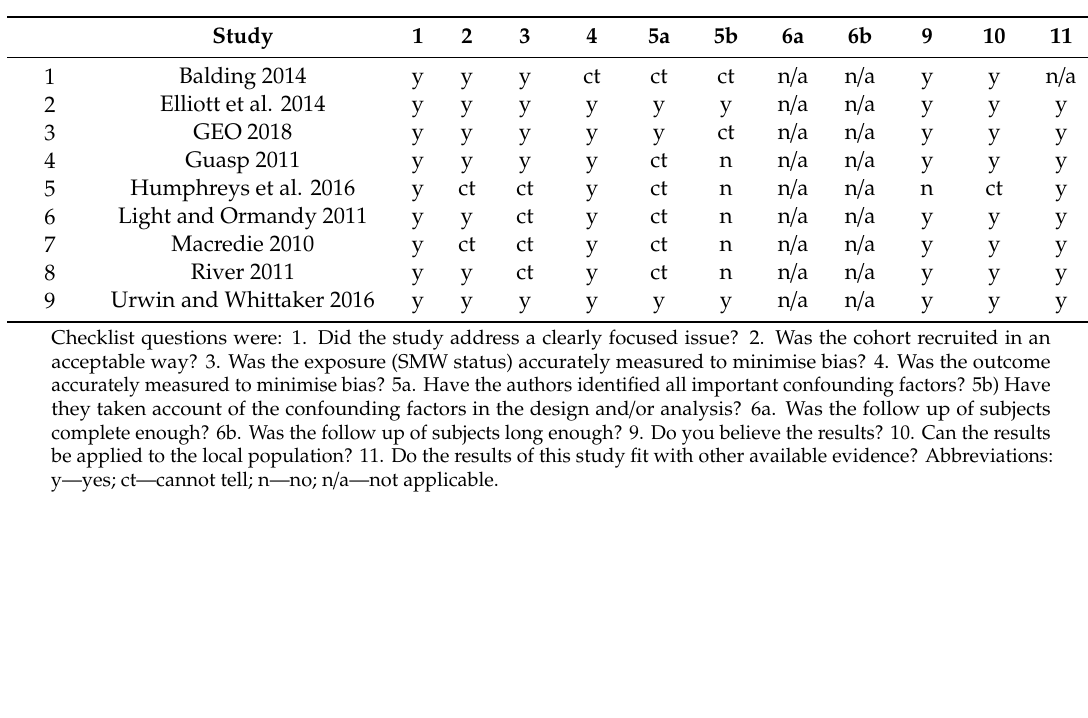
Table 4. CASP quality assessment of quantitative